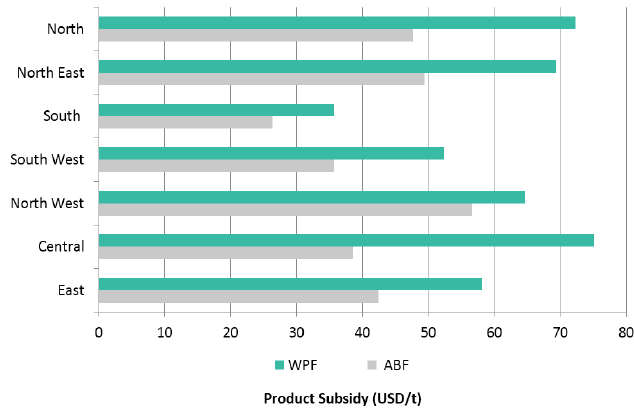
Figure 14. Production ‐ based subsidy for each